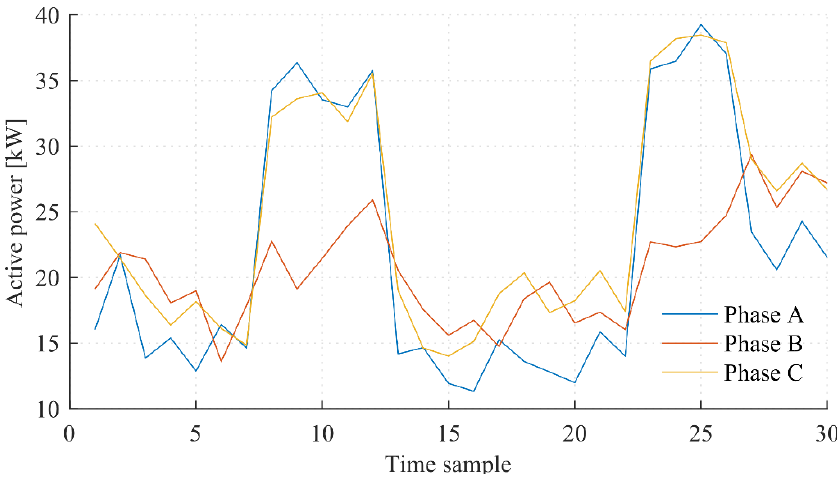
Figure 13. Network consumption — active power — case 4.